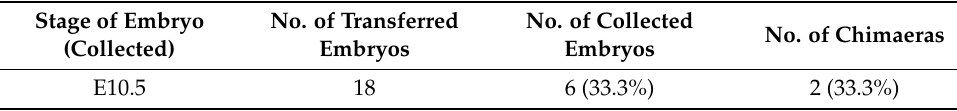
Table 3. The paASCs contributed to the E10.5 chimaera. Stage of